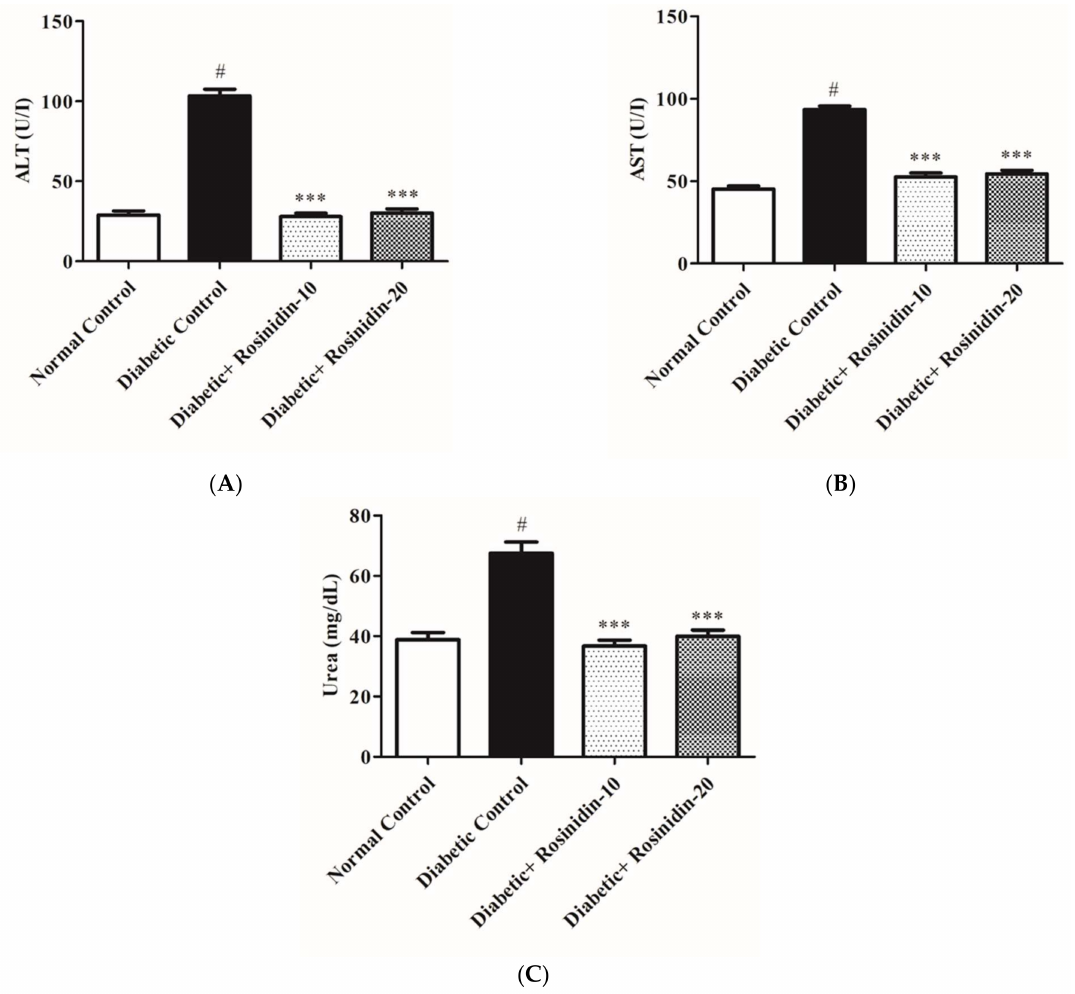
Figure 10. ( A ) Effect of rosinidin on ALT against that of STZ-induced diabetic rats ( n = 6). Values are expressed as mean ± SEM. # p < 0.05, normal control vs. diabetic control; *** p < 0.001, diabetic control vs. rosinidin-10, rosinidin-20. ( B ) Effect of rosinidin on AST against that of STZ-induced diabetic rats ( n = 6). Values are expressed as mean ± SEM. # p < 0.05, normal control vs. diabetic control; *** p < 0.001, diabetic control vs. rosinidin-10, rosinidin-20. ( C ) Effect of rosinidin on urea against that of STZ-induced diabetic rats ( n = 6). Values are expressed as mean ± SEM. # p < 0.05, normal control vs. diabetic control; *** p < 0.001, diabetic control vs. rosinidin-10,